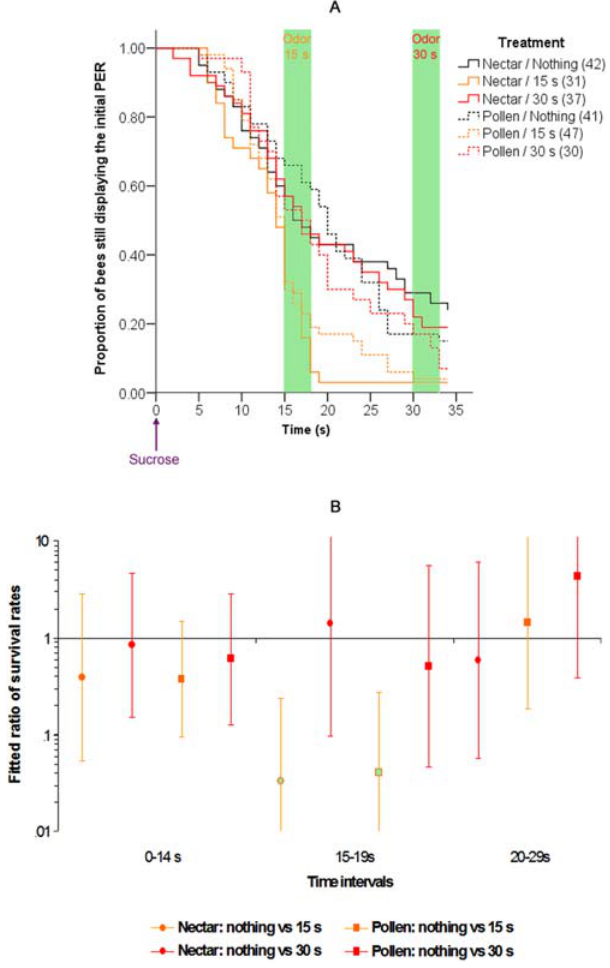
Figure 3. Olfactory interference with nectar and pollen foragers (A, B). This experiment is similar to the one shown in Figure 2, except that both pollen and nectar foragers were used, and that the odor was presented at 15 s, 30 s, or not at all (control group). A, B: details are as in previous figures. In part B, some points are missing because the Cox regression did not converge to a solution for them due to the very low number of bees still displaying a PER after 30 s in the 15 s